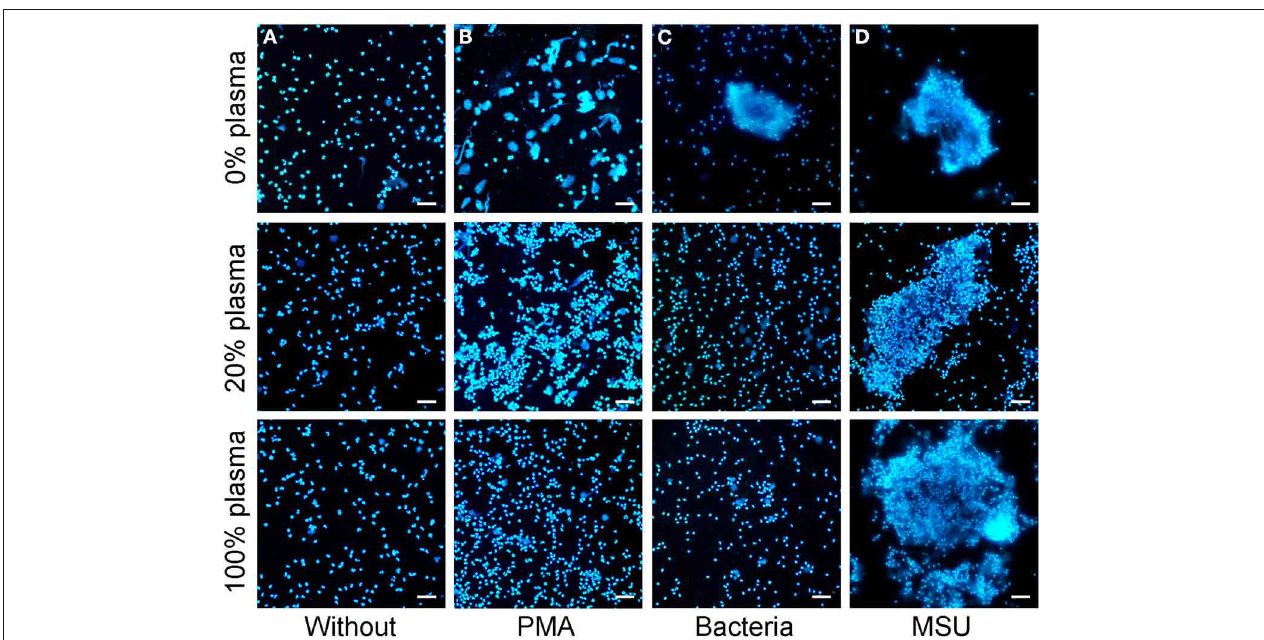
FIGURE 5 | MSU induced NETting of neutrophils is not inhibited by plasma. (A–D) Isolated neutrophils were incubated without stimuli (A) , with PMA (B) , with bacteria (C) , or with MSU crystals (D) in the presence of different concentrations of plasma (0% upper; 20% middle, 100% lower).